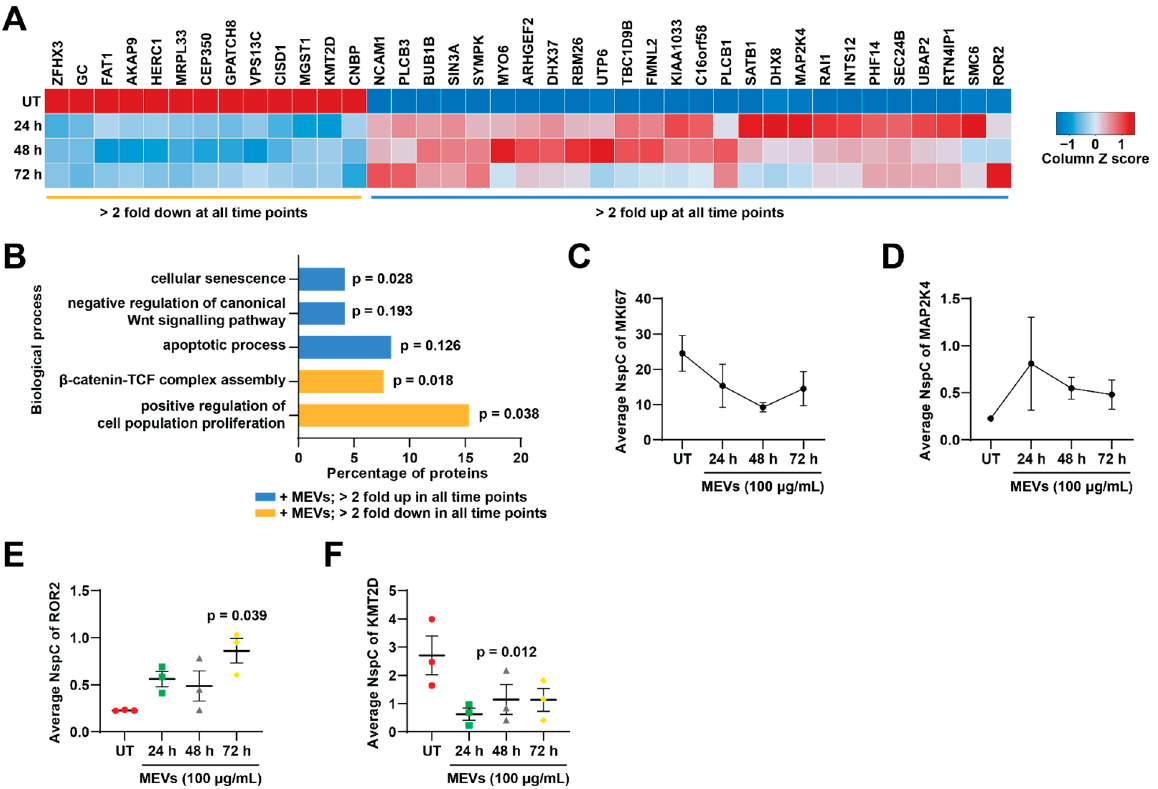
Figure 6. MEV-treated NBL cells were enriched with proteins involved in cellular senescence. ( A ) Heatmap representing the average abundance of proteins that are 2-fold differentially abundant in all the MEV treatment samples compared to the untreated. ( B ) FunRich gene enrichment analysis for biological processes altered due to MEV treatment. ( C ) Average spectral count of MKI67 at different treatment times. ( D ) Normalized spectral count of MAP2K4 upon MEV treatment. ( E ) ROR2 was significantly upregulated in 72 h MEV-treated cells compared to untreated. ( F ) Wnt activator KMT2D was downregulated upon MEV treatment. n = 3- p -vales are determined by t